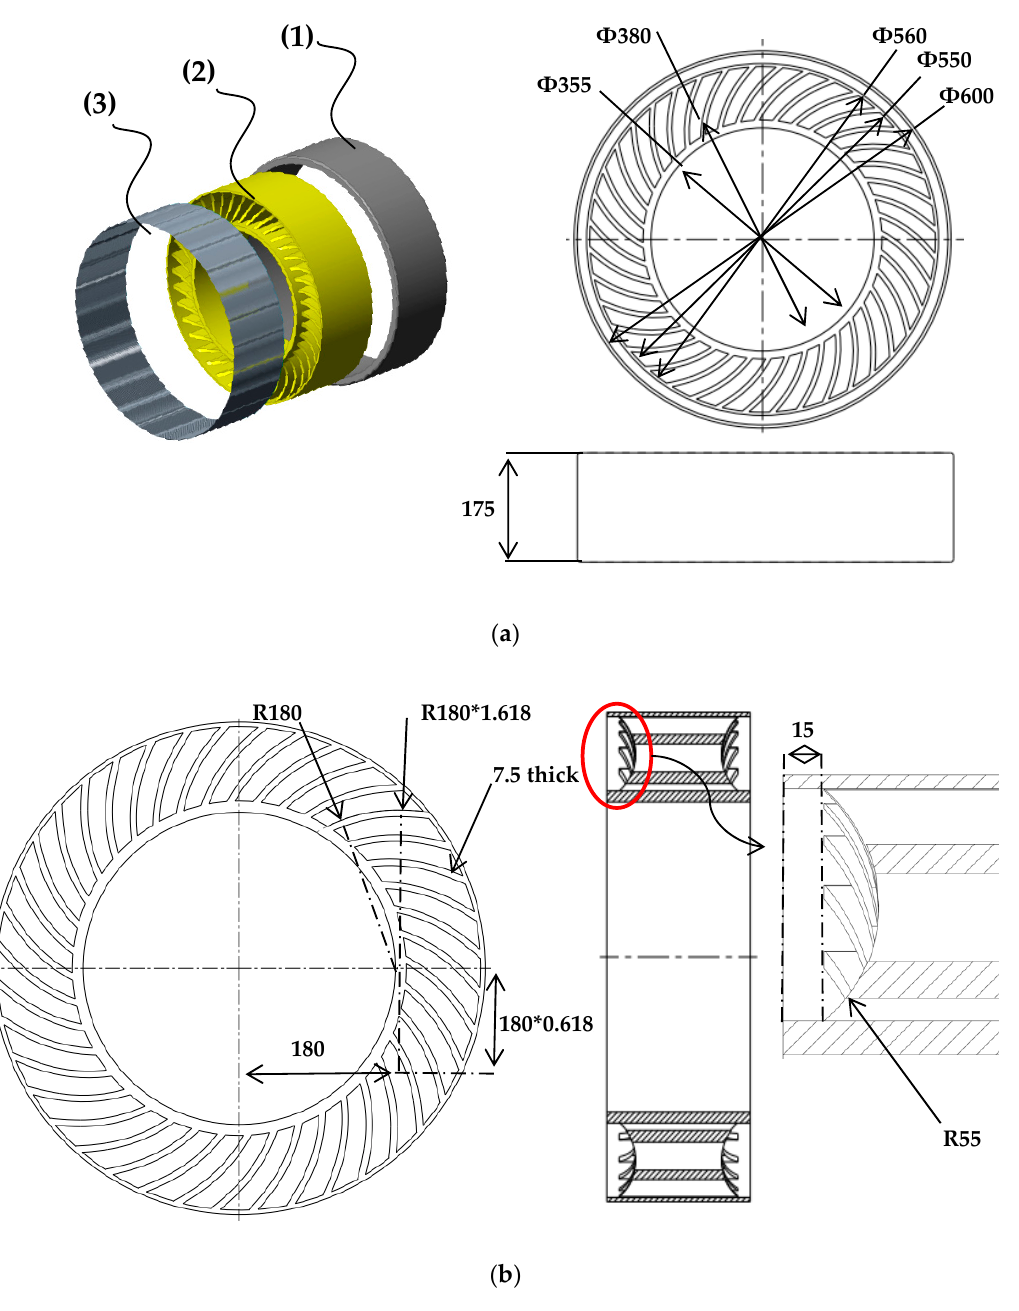
Figure 7. The geometry of the NPT: ( a ) geometric dimensions of the NPT; ( b ) geometric dimensions of the spoke.